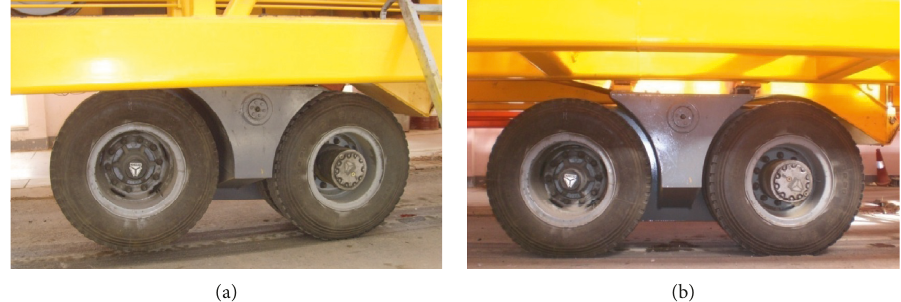
Figure 11: Loading modes: (a) single-axle loading mode; (b) dual-axle loading mode.